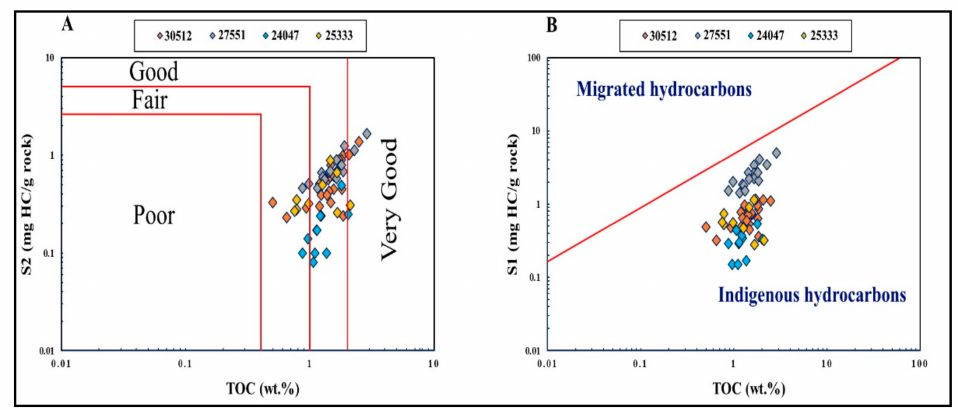
Figure 3. Cross plots of TOC and both S 2 and S 1 for the analyzed samples. ( A ) Displaying the organic richness. ( B ) The organic matter